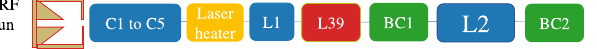
FIG. 8. Updated accelerator design, with the addition of the injector beam line and a laser heater